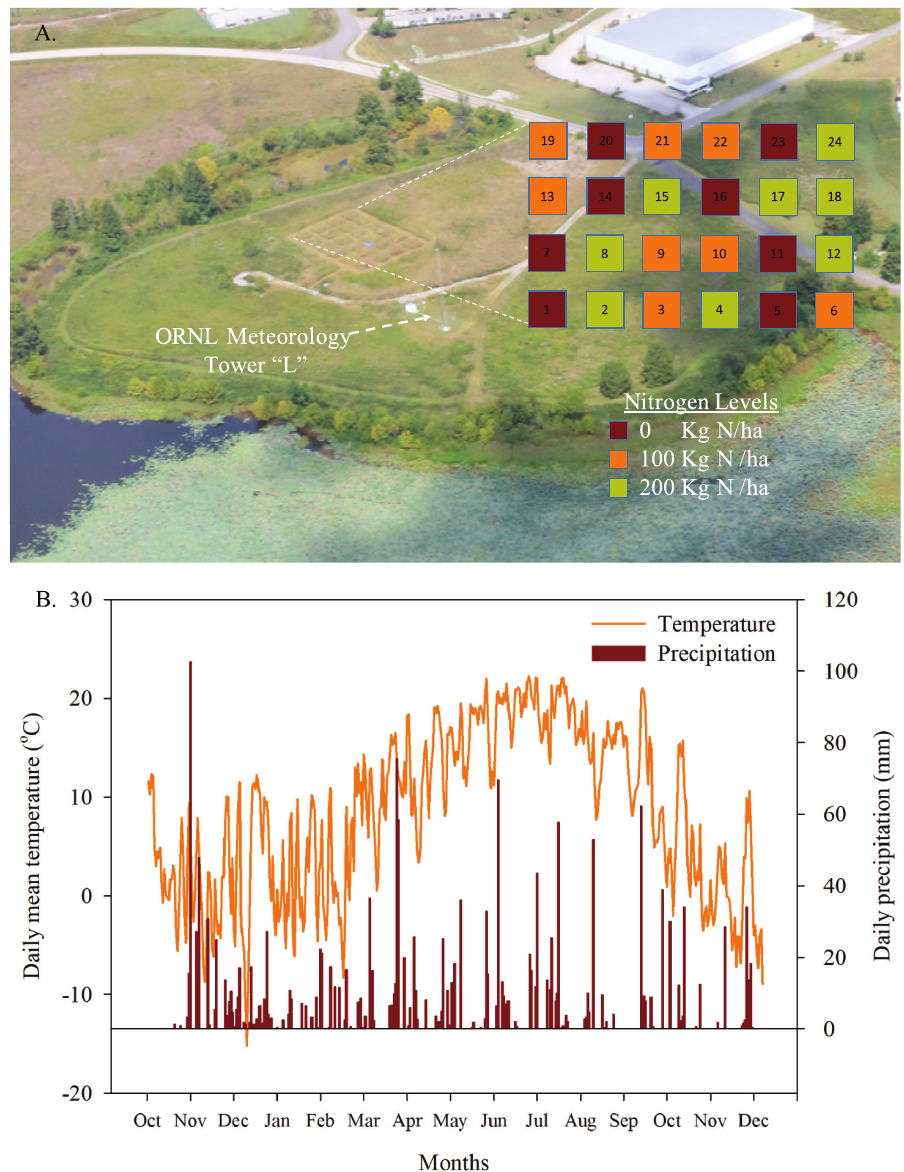
Fig 1. A. An ariel photograph from August 2018 showing the layout of twenty four plots (5 m × 5 m) with three N fertilization levels (0, 100, and 200 kg N ha -1 ) and eight replicates based on a complete randomized design. B. Daily mean temperature and precipitation (November 2016 to December 2017) from the adjacent meteorological tower in Oak Ridge, Tennessee, USA. fall senescence (November 13, 2017) above-ground biomass of switchgrass was measured using a sickledrat to harvest all aboveground biomass from a 0.1 m 2 area at four randomly cho- sen locations in each plot [33]. The four samples of aboveground biomass were pooled by plot in paper bags, oven dried at 70˚C, and weighed to determine dry mass per unit area. A sub- sample of the plant material was then ground into powder using a laboratory mill before total C and N were determined by dry combustion method using a Perkin-Elmer 2400 CHN ana- lyzer (Perkin-Elmer Corporation, Norwalk, CT, USA).